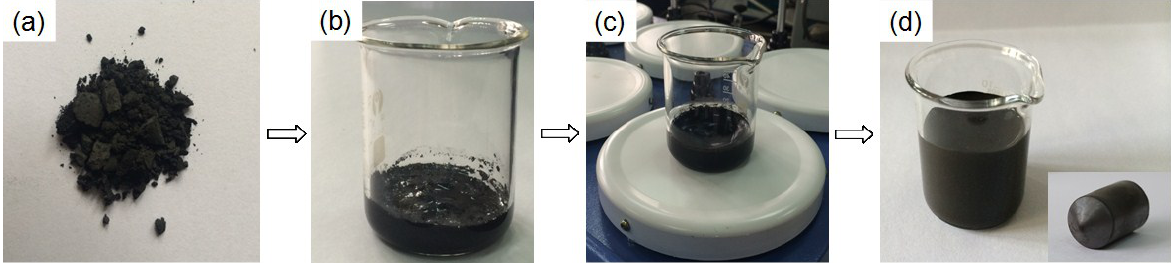
Figure 2. Schematic diagram of fabrication procedure of secondary slurry: ( a ) chips; ( b ) adding solvent; ( c ) heating and stirring; ( d ) secondary slurry and green body (bottom right in Figure